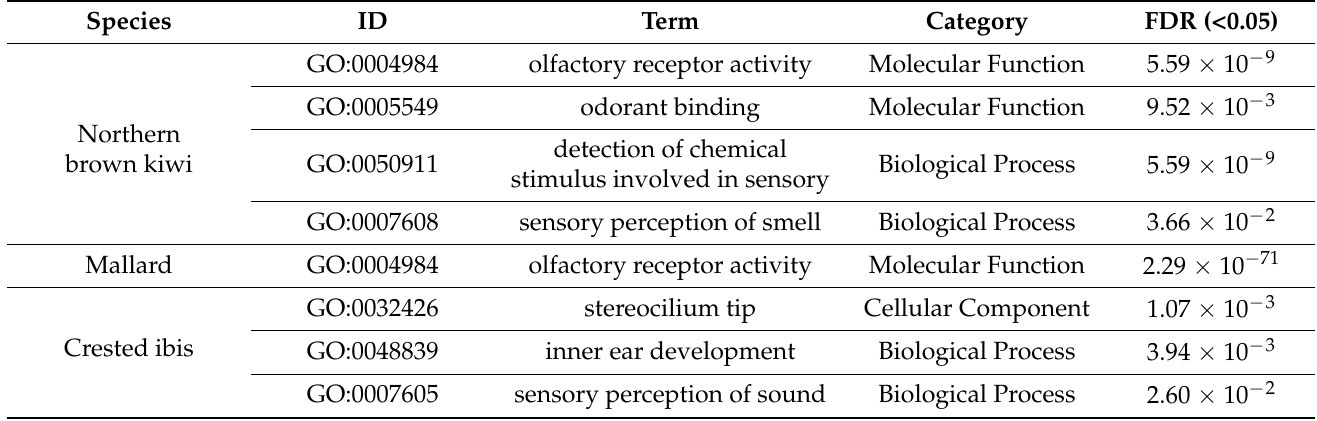
Table 1. Gene ontology (GO) terms related to the development of sensory systems in expanded genes of tactile